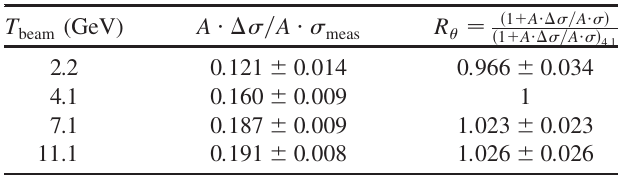
TOWARDS THE OPTIMAL ENERGY OF THE PROTON . . TABLE I. Estimated incremental acceptance-weighted cross section, A (cid:4) (cid:1) (cid:5) , in the unmeasured region (cid:2) < 350 mrad , as a fraction of the measured A (cid:4) (cid:5) meas for (cid:2) > 350 mrad . T beam (GeV)